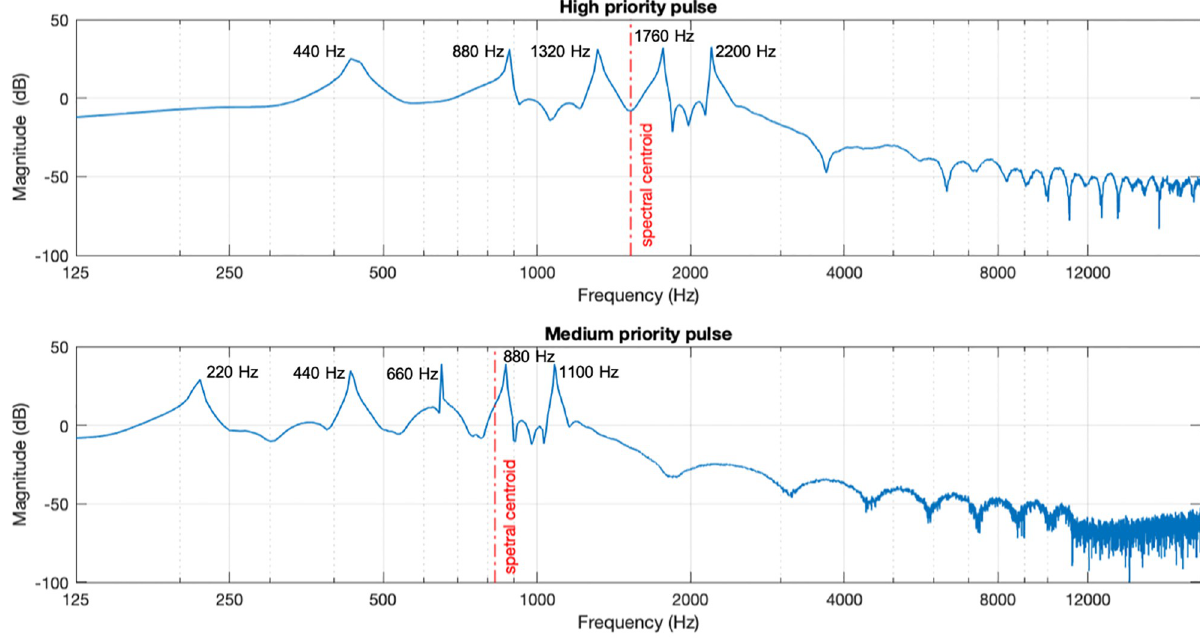
Fig 3. Spectral components of the HP (top) and MP (bottom) pulses. Spectral centroid frequency is represented by the vertical dashed line. Both pulses conform to the updated standard suggestion of having five peaks in the 150 Hz to 4000 Hz range, and with the HP signal being higher pitched than the